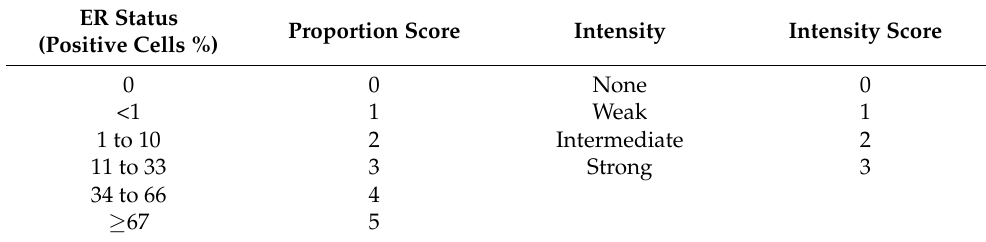
Table 1. Allred score * for estrogen and progestrone receptor evaluation.